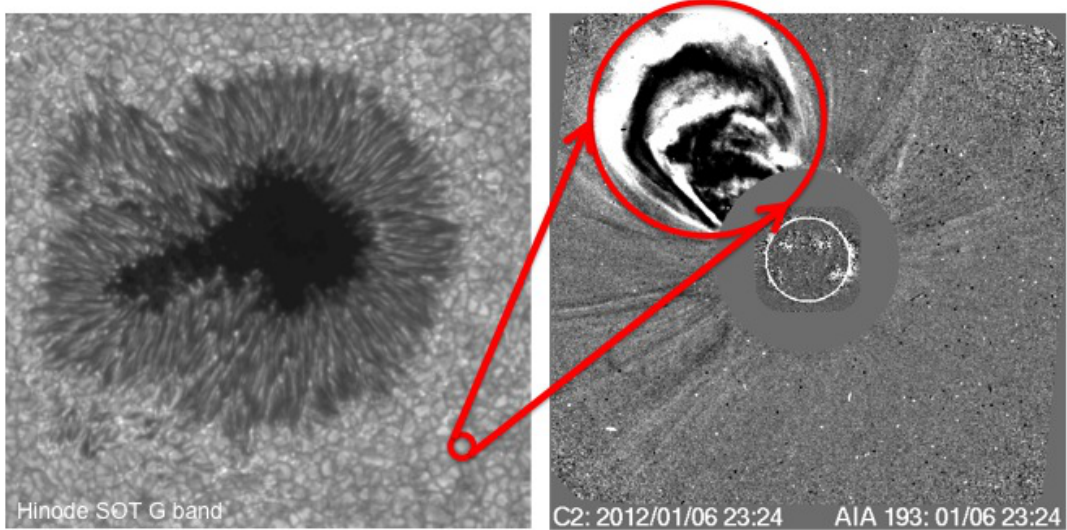
Figure 13: The solar atmosphere is strongly stratified: the mass contained in a single granule (left, Hinode SOT image of a sunspot surrounded by granulation) is comparable to the mass content of the largest CMEs (right, composite of running difference images from the SOHO/LASCO C2 and SDO/AIA instruments. Both quantities are of order 10 16 g. (Credit for right image: NASA CDAW Data